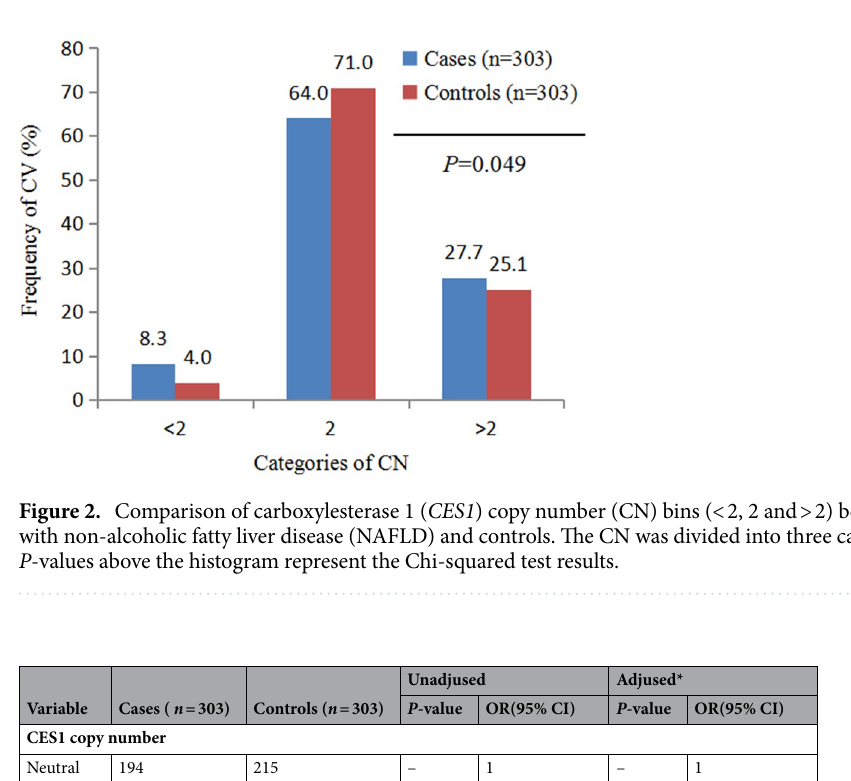
Figure 1. Comparison of the distribution of carboxylesterase 1 ( CES1 ) copy number (CN) between subjects with and without non-alcoholic fatty liver disease (NAFLD). P -values above the histogram represent the Chi- squared test results.